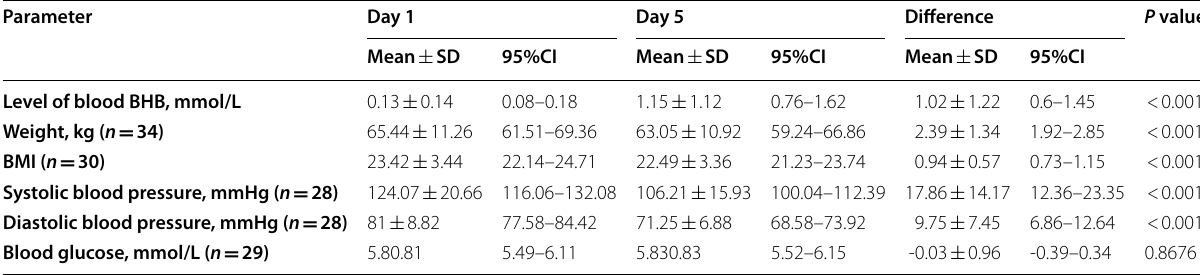
Table 2 Effects of Qigong Bigu practice on physiological parameters Parameter